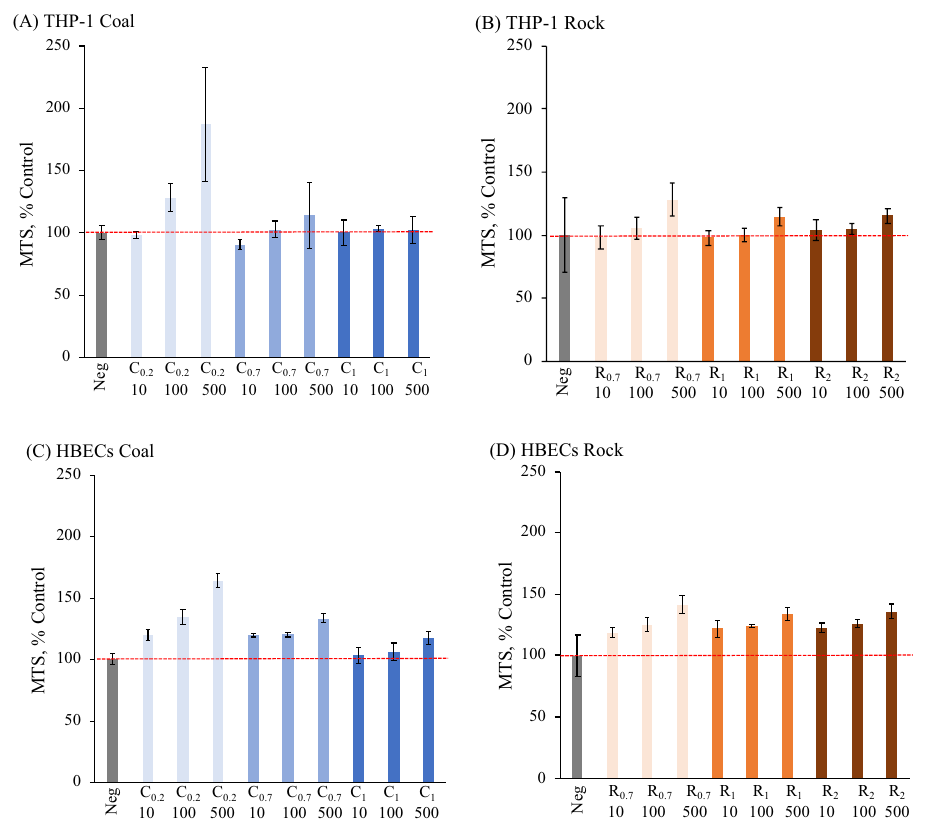
Figure 3. MTS analysis for ( A , B ) THP-1 cells and ( C , D ) HBECs of various coal and rock treatments (10, 100, 500